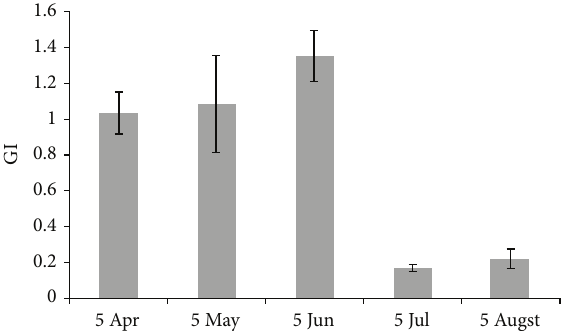
Figure 4: Mean of gonadal index (GI) of Phrynocephalus maculatus from April to August.